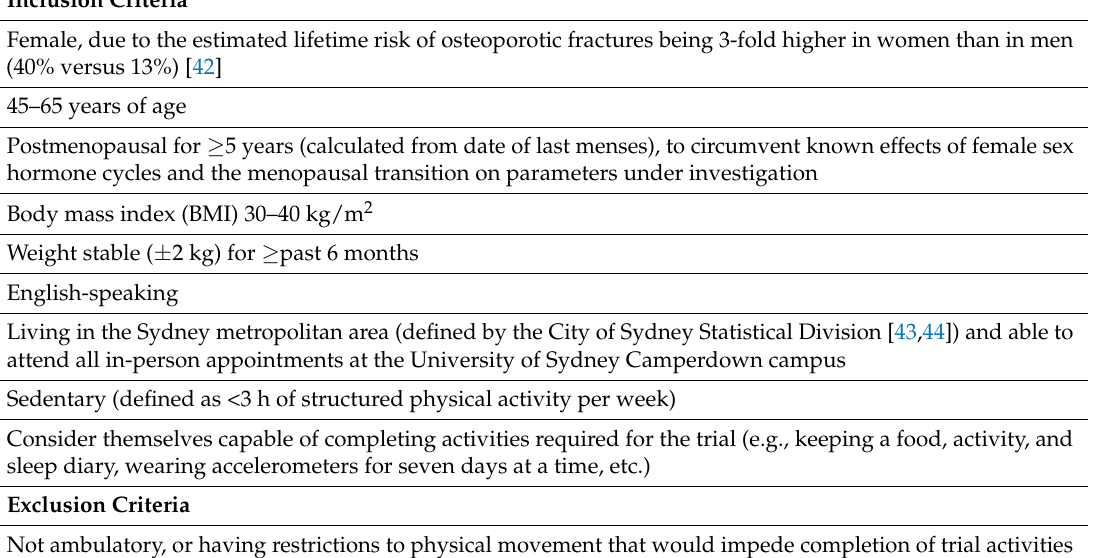
Table 1. Inclusion and exclusion criteria for the TEMPO Diet